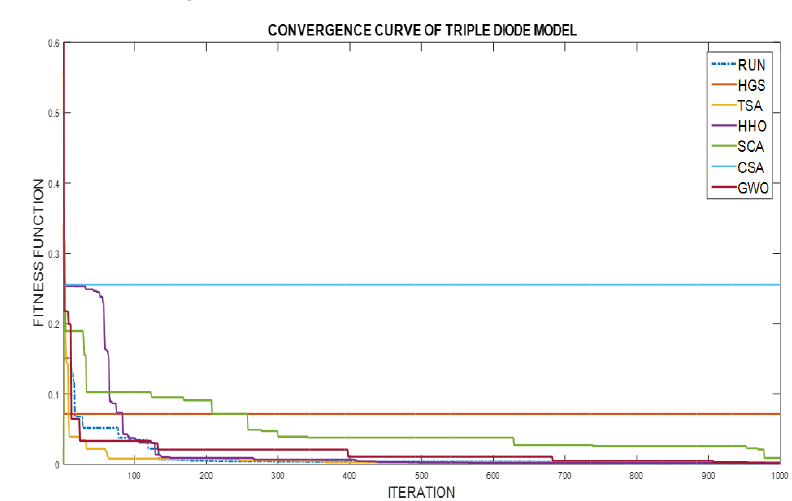
Figure 14. Convergence curve for DDSCM.